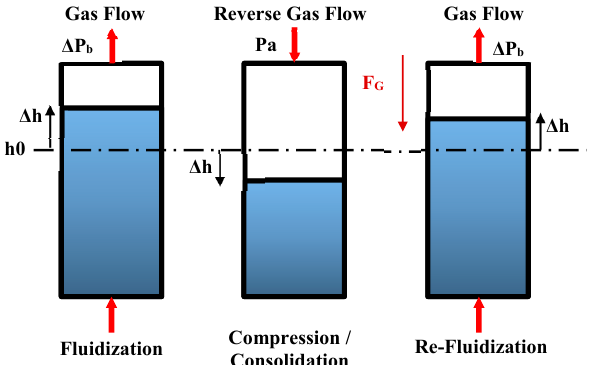
Figure 3. Working principle for each experiment, involving three steps (Fluidization, Compression, and Re-fluidization).